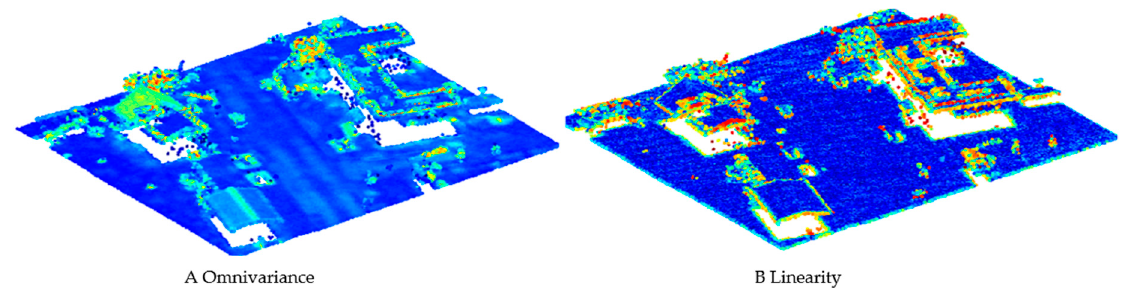
Figure 5. Structure features derived from lidar data: omnivariance ( A ) and linearity ( B ) from [171] .